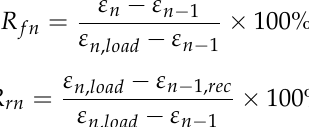
were calculated by Equations (2) and (3), respectively. The symbol n represents the number of